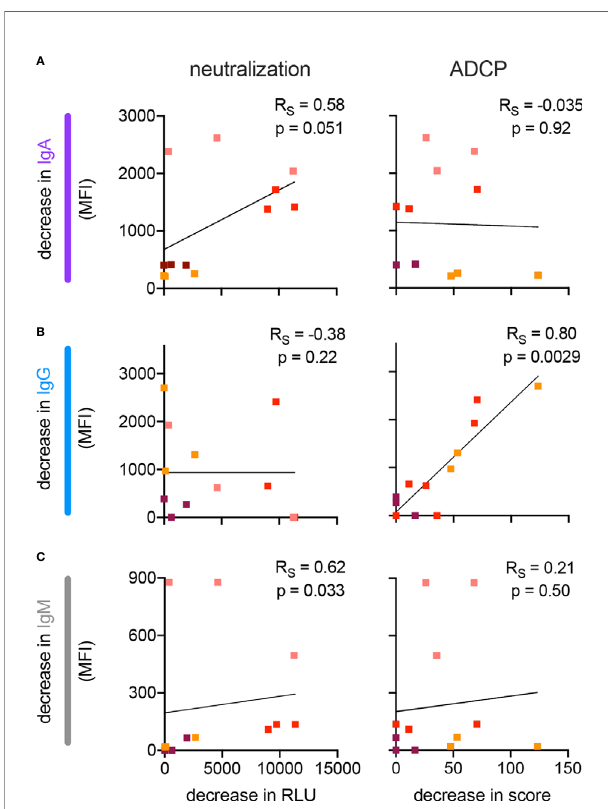
FIGURE 6 | Impact of isotype depletion on antibody functions in nasal wash samples. (A – C) Scatterplots depicting the relationship between the extent of depletion of IgA (A) , IgG (B) , and IgM (C) and neutralization (left) and monocyte phagocytosis (right, ADCP) in nasal wash samples. Samples from four different individuals (indicated in color) were processed to deplete each of the three isotypes. Best fi t line is illustrated. Spearman correlations (R S ) and two-tailed signi fi cance values are indicated in